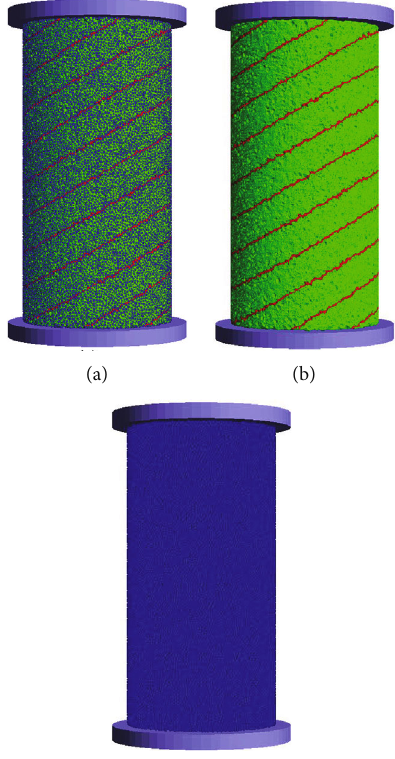
Figure 4: The application of boundary conditions. Where (a) represents the particle-solid bond model, (b) represents the solid bond (green represents the matrix solid bond, red represents the bedding solid bond), and (c) represents the particle model.